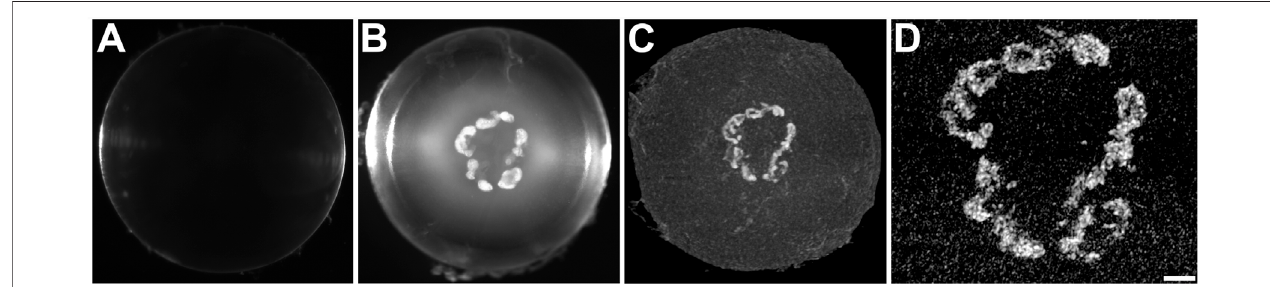
FIGURE 1 | The distribution of the high X-ray attenuating material in Cx46fs380 lenses coincides with that of the cataract. (A,B) Dark fi eld images of Cx46fs380 lenses from 171-day-old wild-type (A) and homozygous (B) male mice. (C) Three-dimensional projection of the micro-CT images from the homozygous lens shown in (B) . (D) Magni fi edviewofthecentral regionofthethree-dimensionalprojectionofthehomozygouslensshown in (C) . Thescalebar represents331 µmfor panels (A,B) , 300 µm for panel (C) , and 100 µm for panel (D) .